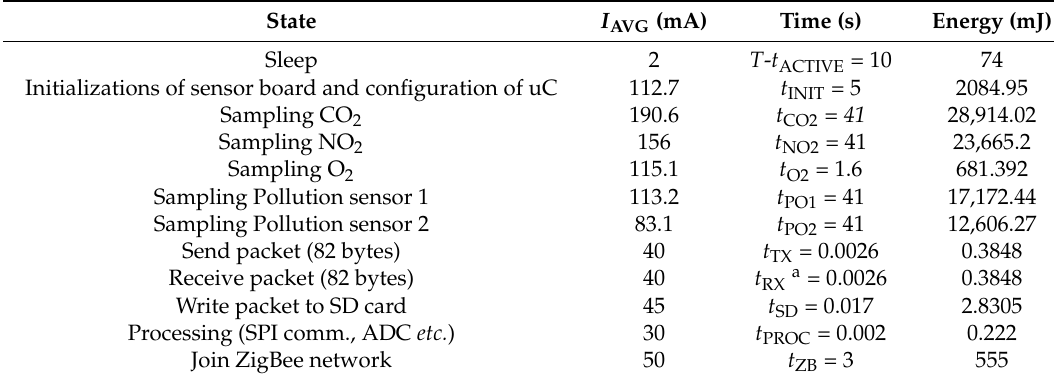
Table 2. Measured average current consumption of the Waspmote in different states at supply voltage of 3.7